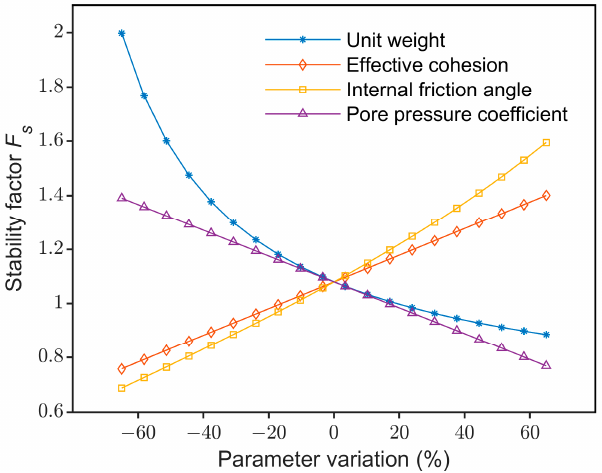
Figure 3. Sensitivity analysis of the input soil parameters.